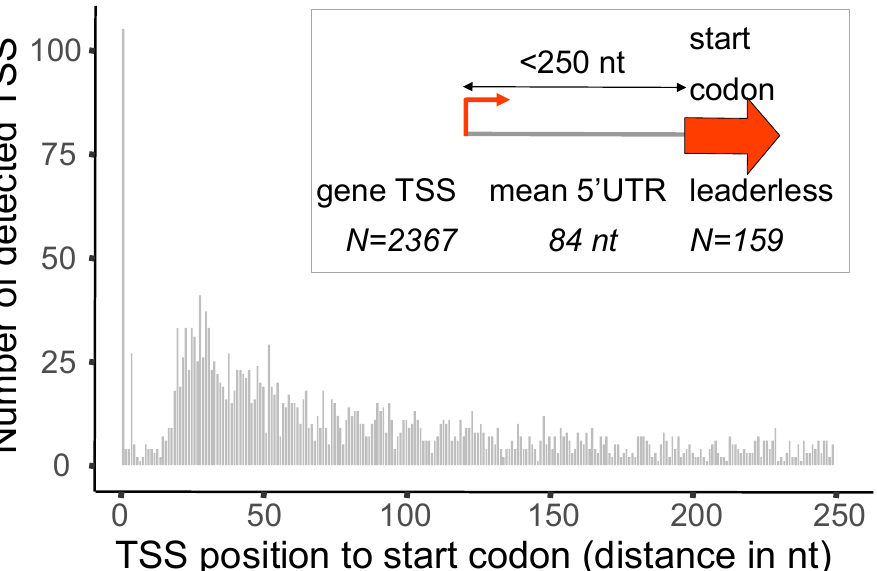
Figure 3. Length distribution of the 5 (cid:48) untranslated region (5 (cid:48) UTR). A 0 distance to start codon represents TSS of leaderless transcripts. In this study, the maximum 5 (cid:48) UTR length was 250